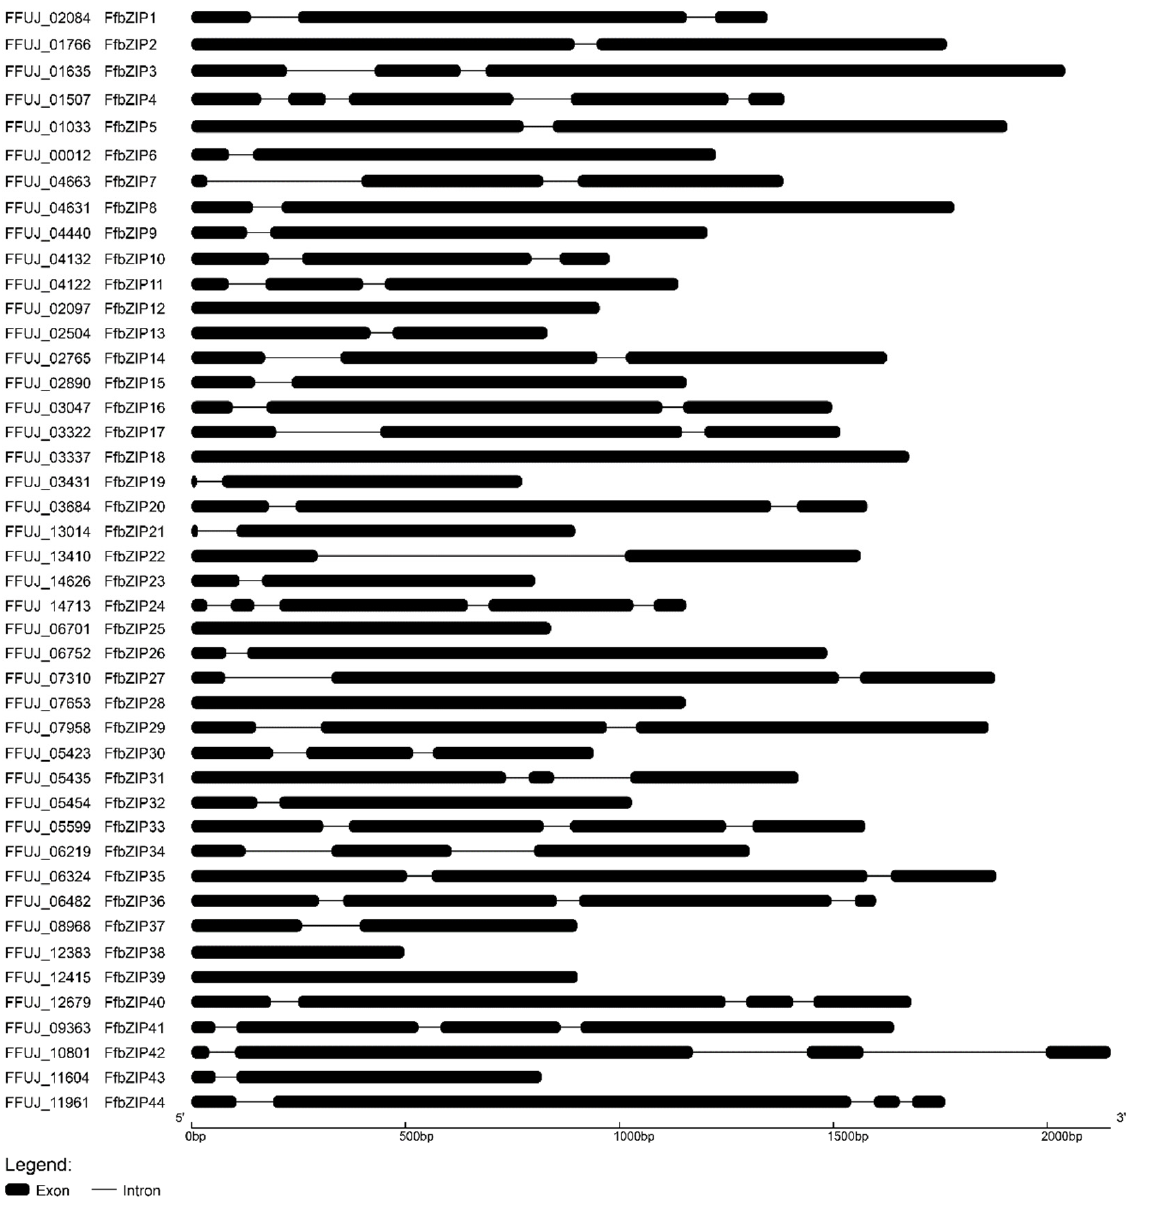
Figure 3. Intron and exon distribution patterns in the coding sequence of FfbZIP genes.